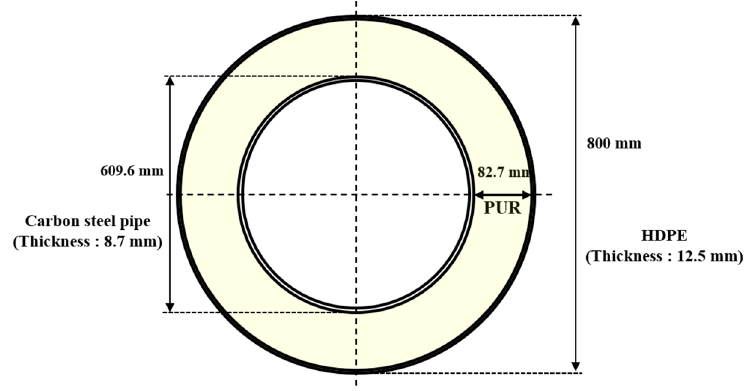
Figure 1. Schematic diagram of the pre-insulated coated pipe (600 A).